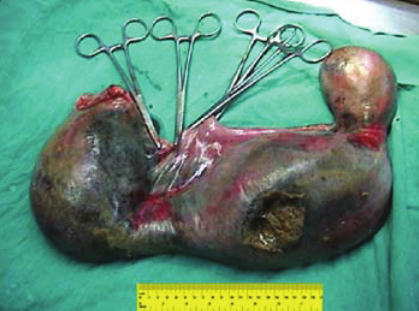
Figure 2: The appendix was perforated in the middle